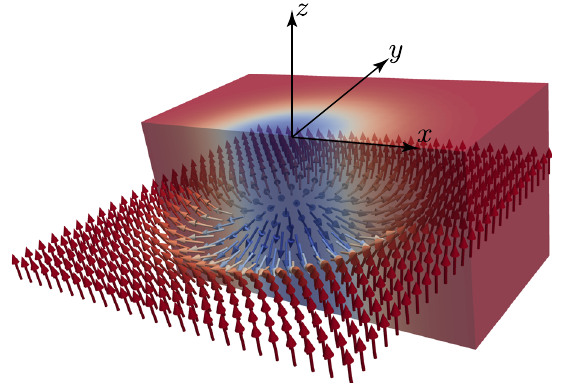
FIG. 1. Illustration of a magnetic layer hosting a Skyrmion with topological number Q ¼ 1 embedded in a bulk magnetic insu- lator. The magnetization m ð ~ r Þ is assumed to be uniform along the direction perpendicular to the